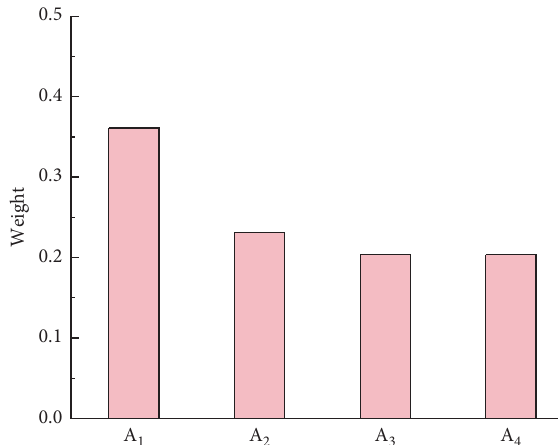
Figure 6: Schematic diagram of comprehensive weight of criterion layer.